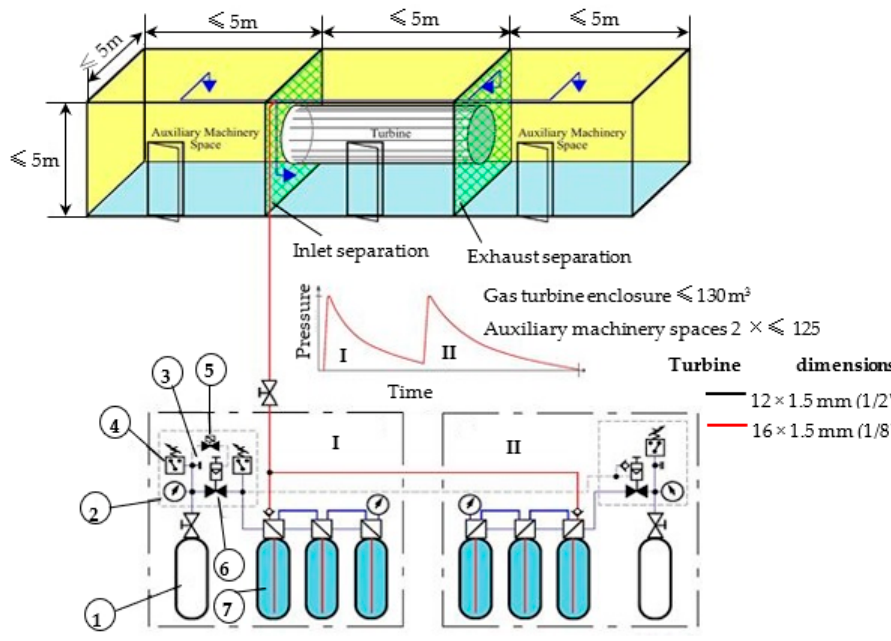
Figure 26. Marifoff HI-FOG installation example for a turbine enclosure [93].